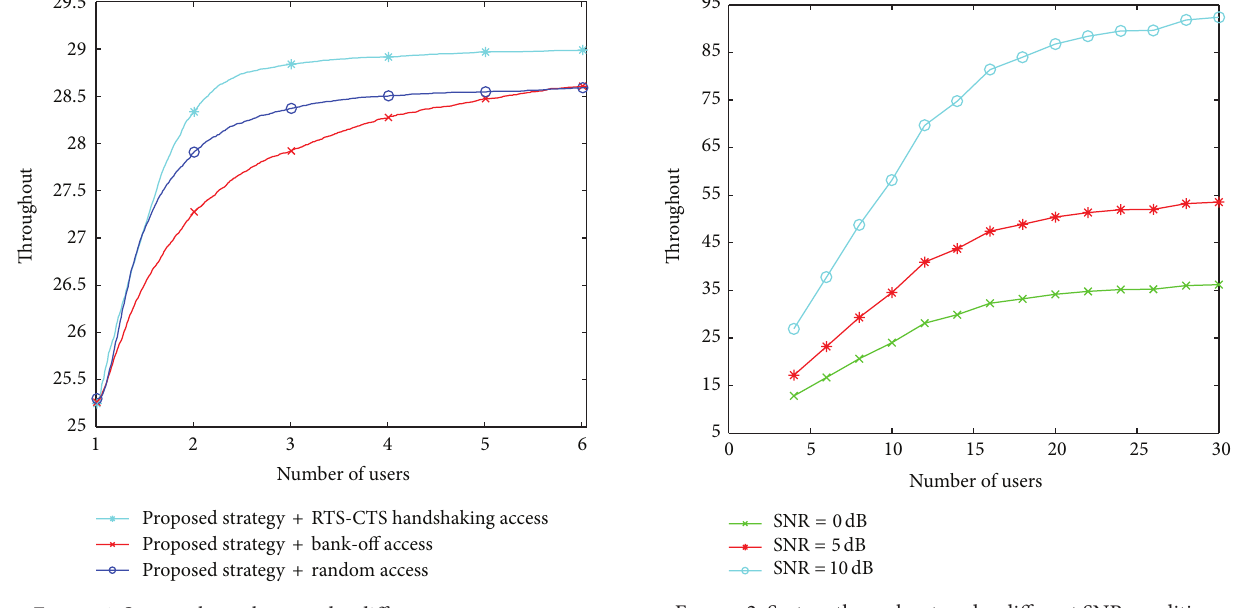
Figure 1: System throughput under different access strategy. Figure 2: System throughput under different SNR